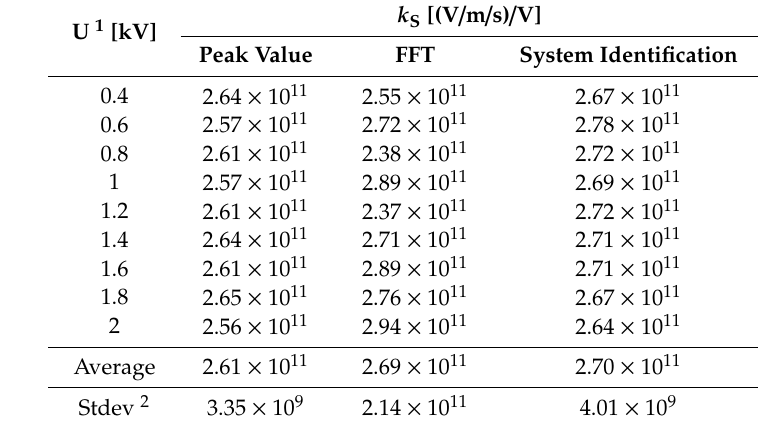
Table 2. Comparison of sensitivity coefficient calibration methods.